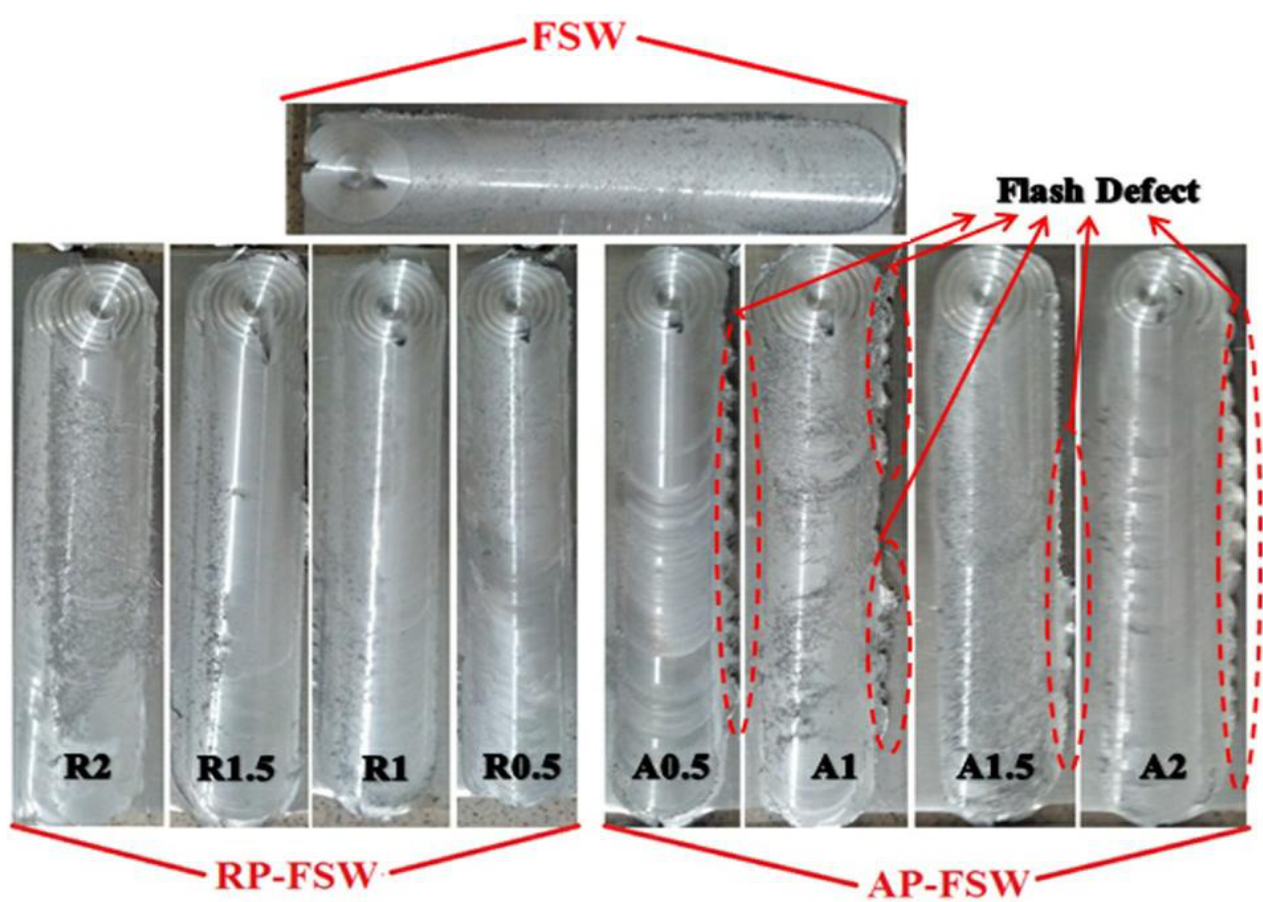
Figure 6. Surfaces of welded specimens by three introduced welding techniques.